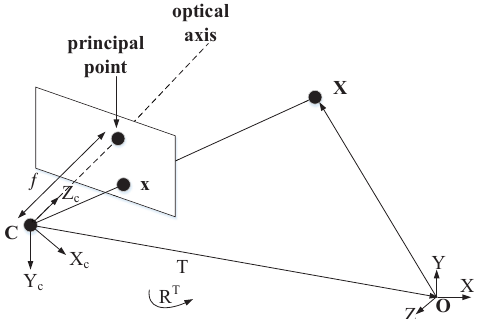
Figure A1. Pinhole projection of a 3D point X onto a camera image plane. The extrinsic parameters of the camera R , T represent the rigid body transformation between the world XYZ coordinate system and the camera X c Y c Z c coordinate